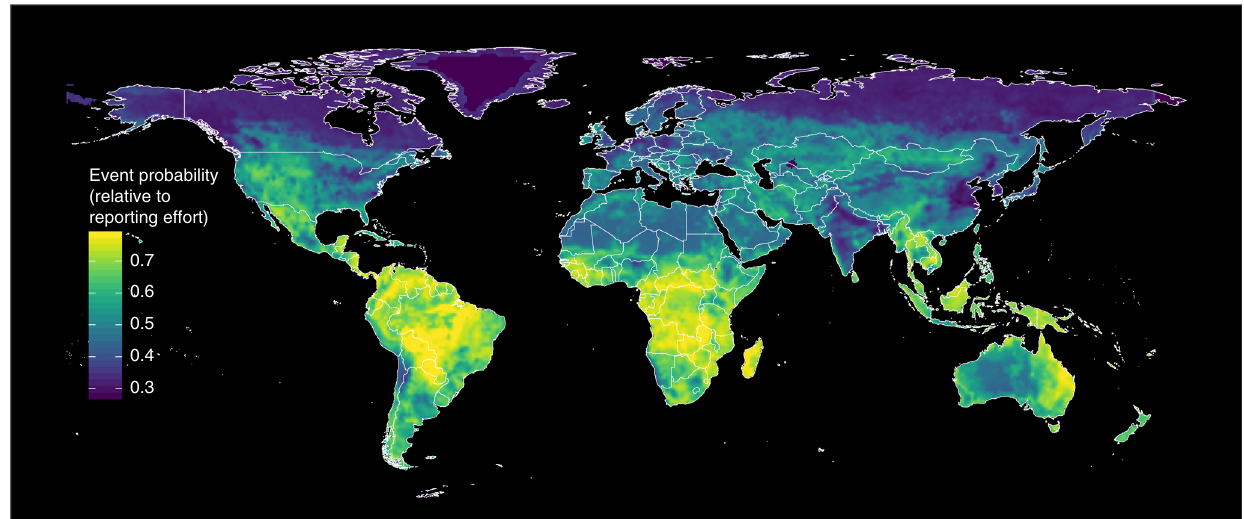
Fig. 4 Heat map of weighted model response, i.e., EID risk relative to reporting effort. Value indicates the binomial probability that a grid cell sampled at that location will contain an EID event as opposed to a background sample, when drawing equal numbers of absence and background samples weighted by reporting effort (see Methods section). This layer was weighted by reporting effort to produce the “ observed ” EID risk index map (Fig. 3a) and by population to produce the risk index map with bias factored out (Fig.